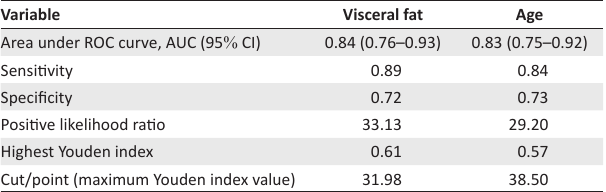
TABLE 2: Values from receiver operating characteristic curve for visceral fat and age.